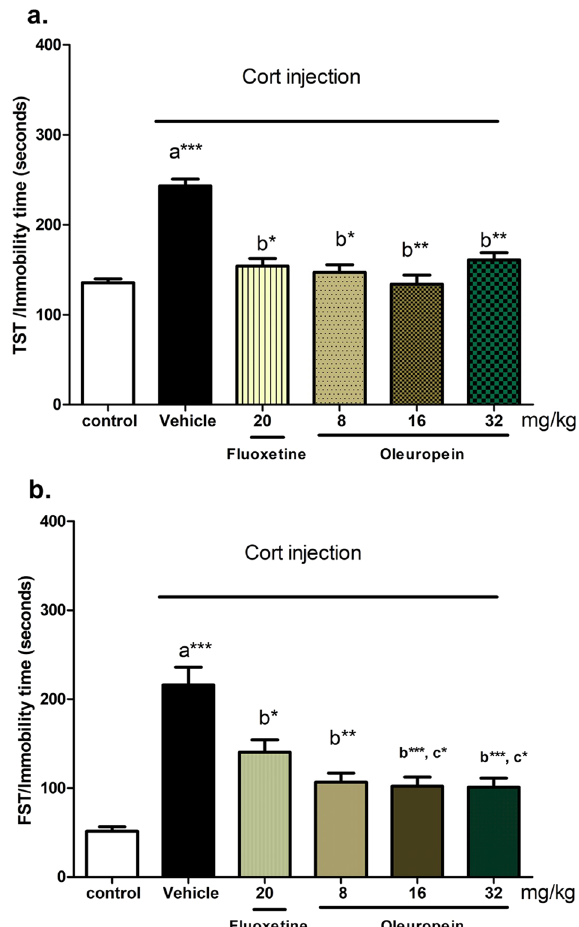
Figure 1. Effects of different doses of oleuropein on immobility time in chronic Cort-induced depression model. ( a ) Tail Suspension Test (TST) and ( b ) Forced Swimming Test (FST) in different animal groups. Each bar represents the mean of 6 rats + SEM. a: significant compared to the control group; b: significant compared to the Cort group; c: significant compared to Cort + Fluoxetine group; d: significant compared to Cort + oleuropein (8 mg/kg) group. * p ≤ 0.05, ** p ≤ 0.01, *** p ≤